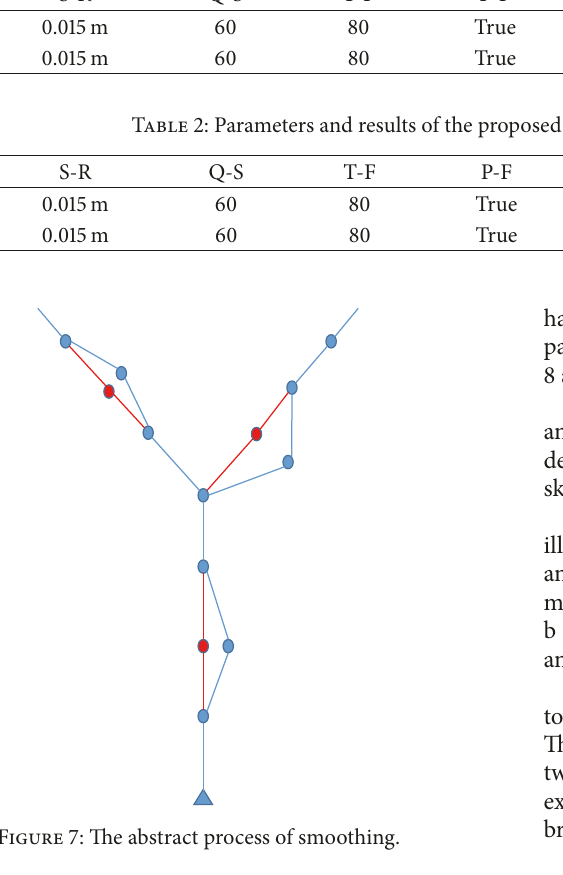
their coordinates (𝑥, 𝑦, 𝑧) . The NEW A ’s three-dimensional coordinates would replace the current skeleton node A . The processing is shown in Figure